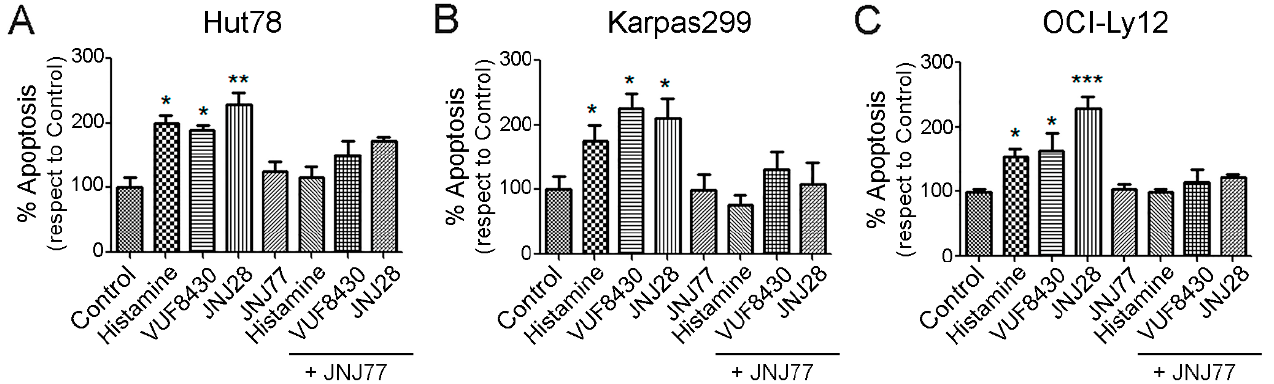
Figure 3. Modulation of apoptosis in HuT78, Karpas299, and OCI-Ly12 cells by histamine and H4R agonists. ( A ) HuT78, ( B ) Karpas299, ( C ) OCI-Ly12 cells were pre-incubated for 24 h in serum-free RPMI medium and then were left untreated (control) or were treated with histamine, JNJ28 or VUF8430 (10 µM) and/or JNJ77 (10 µM) for 48 h in complete medium, and apoptosis was evaluated by Caspase-Glo 3/7 Assay. Measurements were performed in triplicates for each condition and cell line and data are expressed as mean ± SEM ( n = 3 independent experiments). * indicates p < 0.05, ** indicates p < 0.01, *** indicates p < 0.001 compared with Control.